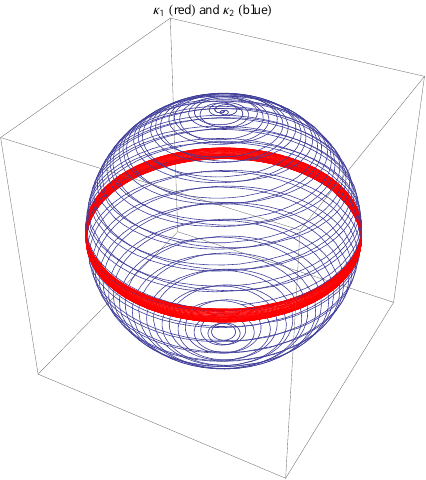
Figure 2. The evolutions of the unit spin vectors in the frame determined by ˆA N , ˆL N × ˆA N and ˆL N . The movement of the dominant spin ˆS 1 and the smaller spin ˆS 2 are depicted in red and blue,